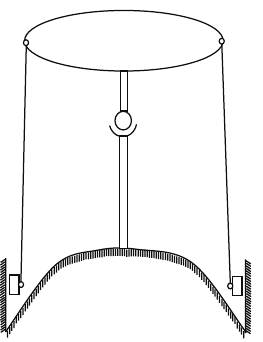
Figure 9: Strut concept of functional